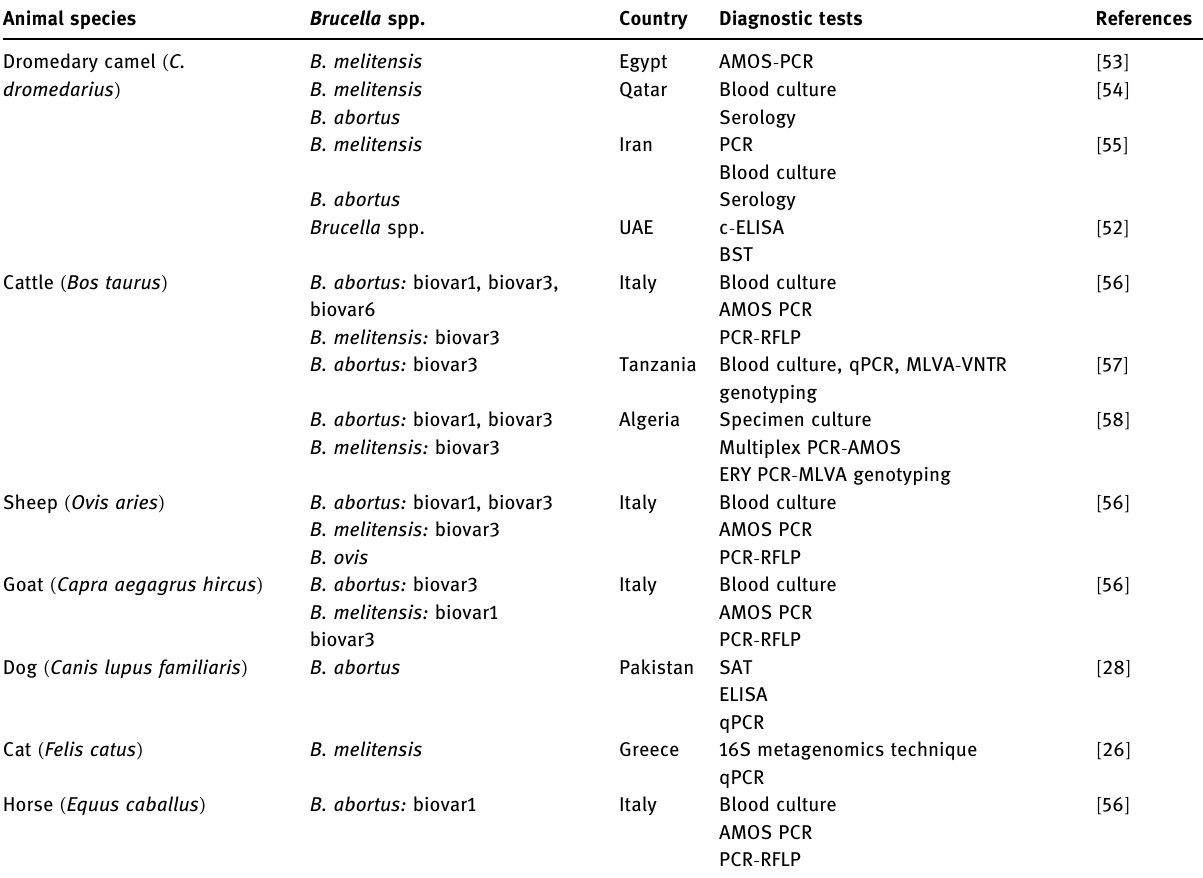
Table 1: Examples of domestic animals ’ infections linked to zoonotic human brucellosis cases, isolated Brucella spp., used diagnostic tests, and concerned countries Animal species